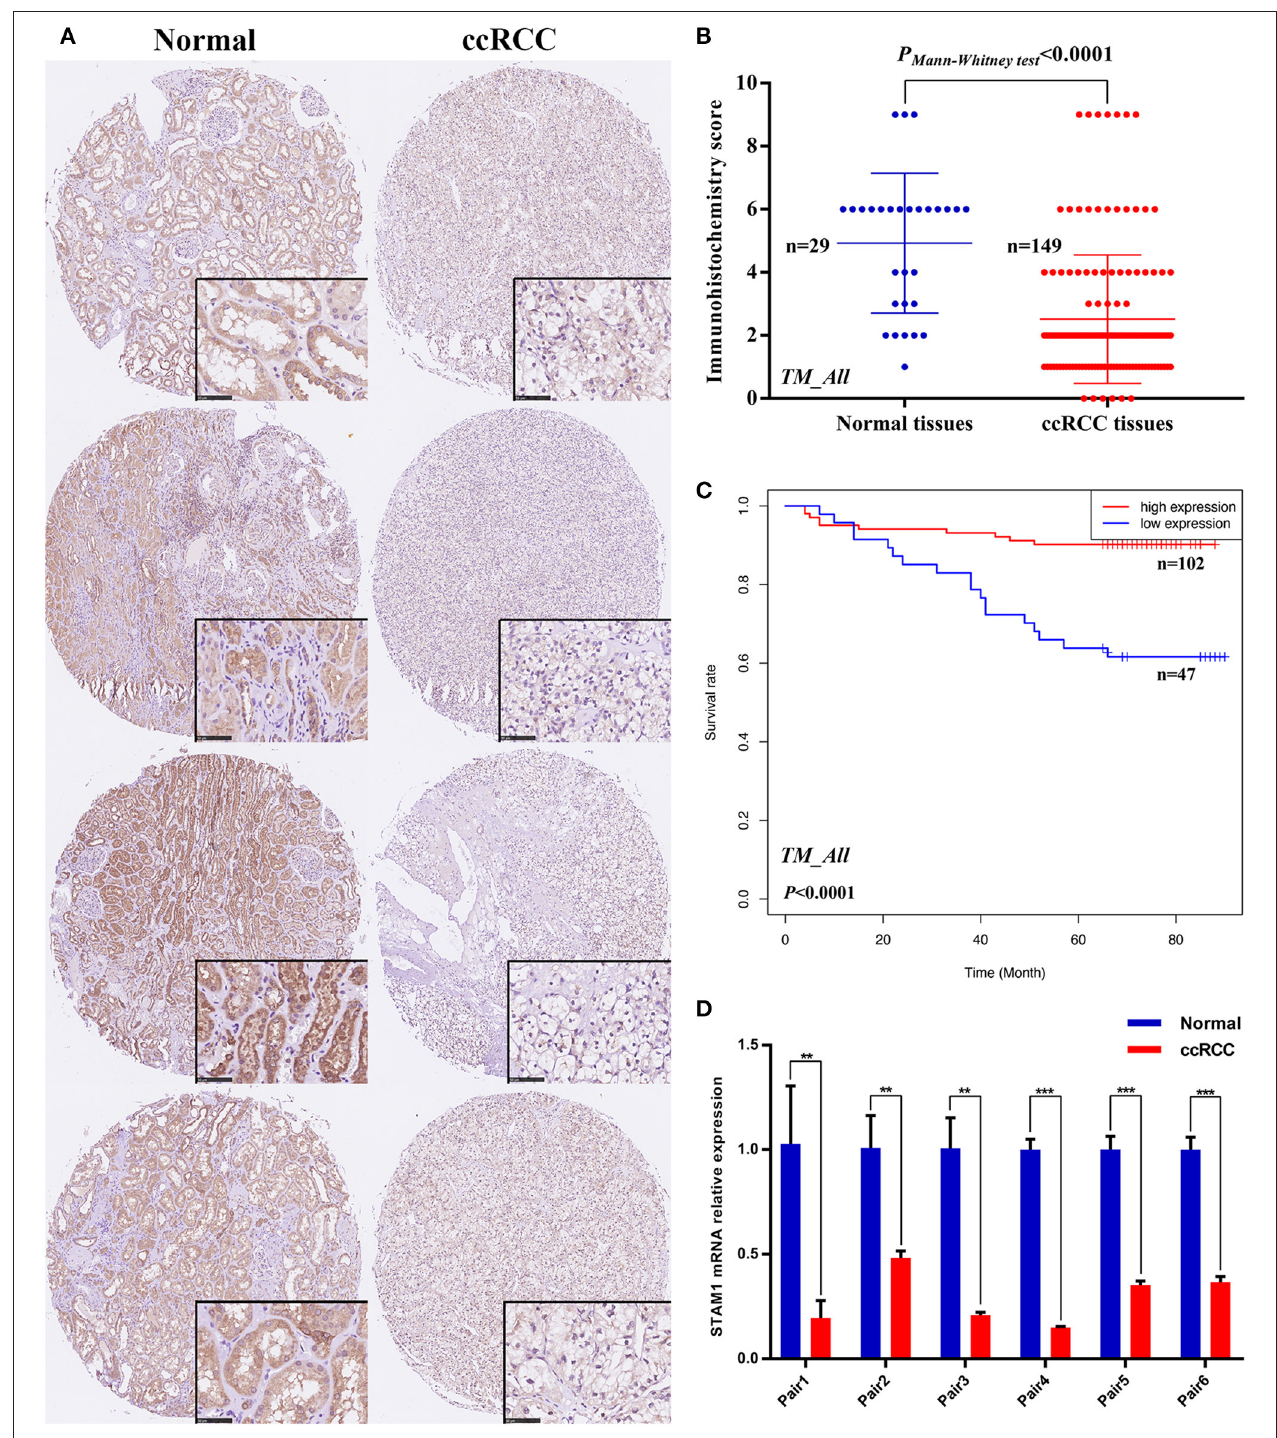
FIGURE 3 | Protein and mRNA expression of STAM1 in tissue microarray (TM) cohort and fresh samples in our hospital; overall survival (OS) based on STAM1 levels in clear cell renal cell carcinoma (ccRCC) from TM cohort. (A) Immunohistochemical (IHC) staining sections for STAM1 of the representative four paired ccRCC tissues and cancer-adjacent normal renal tissues from TM cohort. (B) Comparison of IHC scores of STAM1 between ccRCC tissues and cancer-adjacent normal renal tissues in TM cohort. (C) Kaplan–Meier analysis of OS in patients with low and high STAM1 level in TM cohort according to IHC scores. (D) Comparison of STAM1 mRNA level in six paired fresh ccRCC tissues and cancer-adjacent normal renal tissues from our hospital through polymerase chain reaction. ** p < 0.01, and *** p < 0.001.